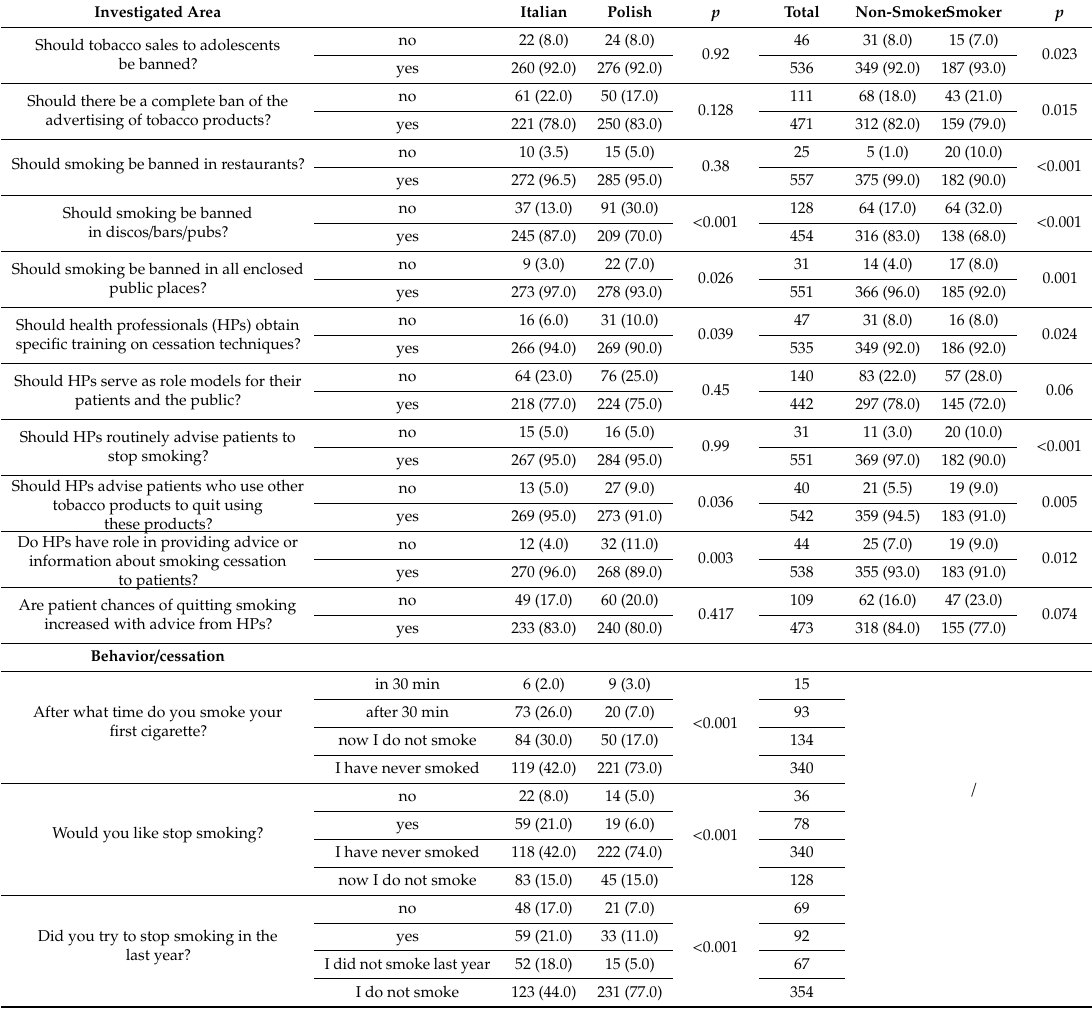
Table 3. Dental students’ beliefs, opinions and attitude toward tobacco